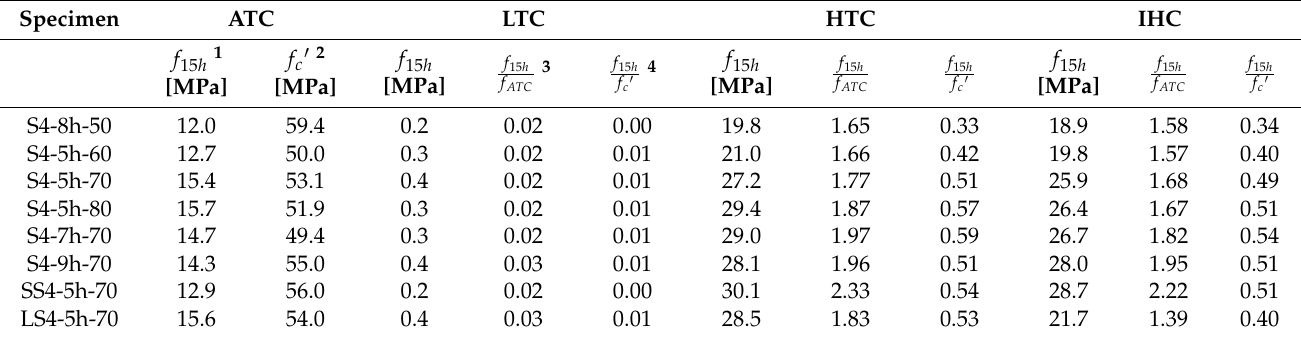
Table 3. Compressive strength